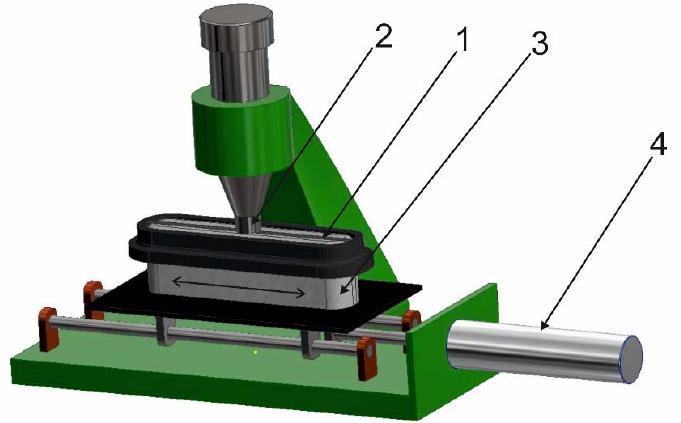
Figure 6. View of the experimental set-up for fastness testing of electro-conductive lines to rubbing.